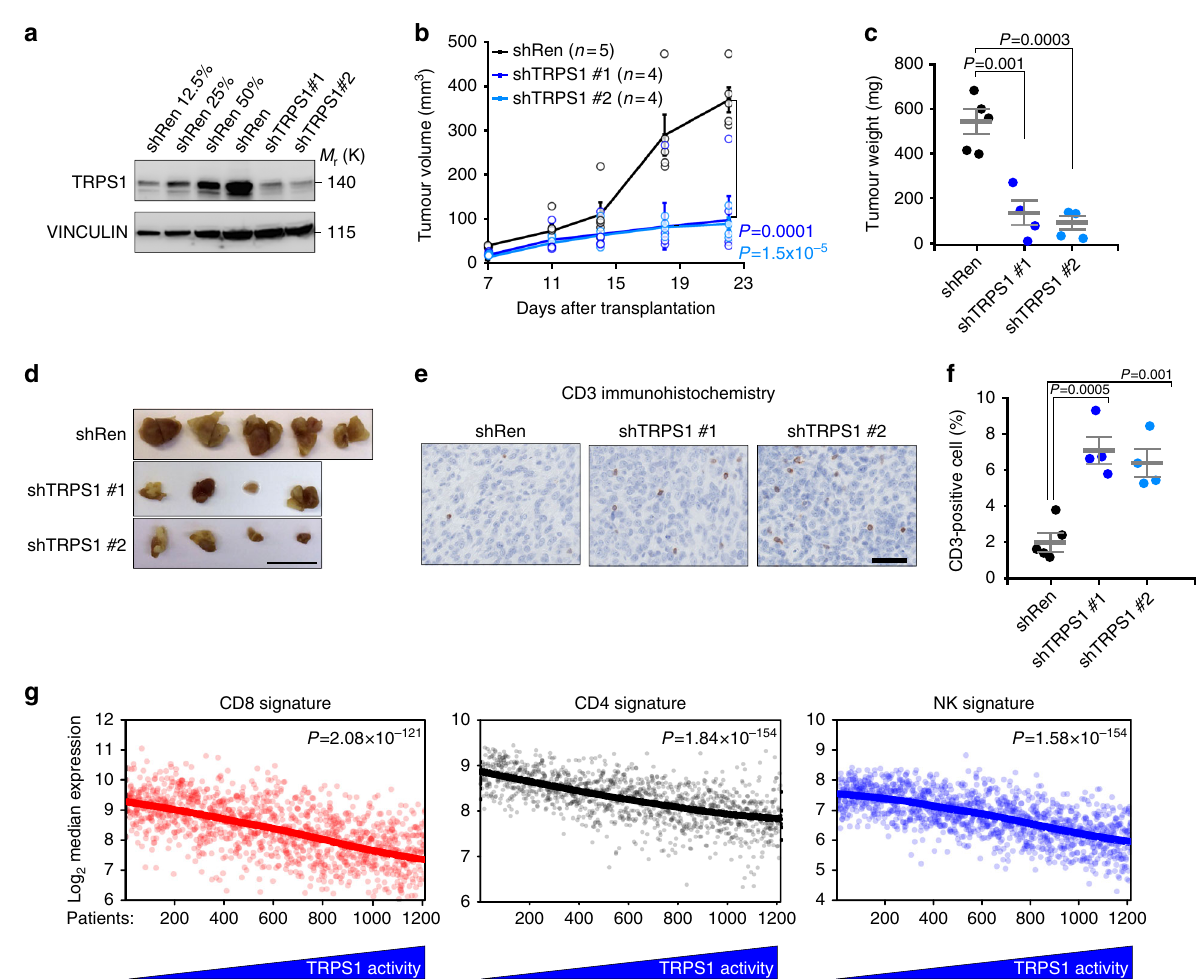
Fig. 8 TRPS1 is needed for ef fi cient tumour growth in vivo. a Western blot for TRPS1 in 4T1 cells infected with two different shRNAs targeting TRPS1 or a non-targeting shRen (Renilla) control, respectively. Serial dilutions (lanes 1 – 3) of the shRen control are loaded to demonstrate the knockdown ef fi ciency. b Tumour growth of 4T1-derived tumours orthotopically transplanted into the mammary gland of BALB/C mice. Tumour size was monitored after the indicated times of injection. Data are presented as means ± s.e.m. Two-way ANOVA test. c The tumour weight of the 4T1-derived tumours was determined 23 days after transplantation. One-way ANOVA test. d Photos of 4T1-derived tumours 23 days after transplantation. Scale bar = 1 cm. e Representative images of IHC stainings for CD3-positive cells (T cells) in sections of the 4T1-derived tumours. Scale bar = 50 μ m. f Quanti fi cation of (k). Error bars represent s.e.m. One-way ANOVA test. g Expression of signature gene sets for natural killers (NK), cytotoxic T cells (CD8) and helper T cells (CD4) were sorted based on TRPS1 activity in breast cancer patients. Spearman rank correlation